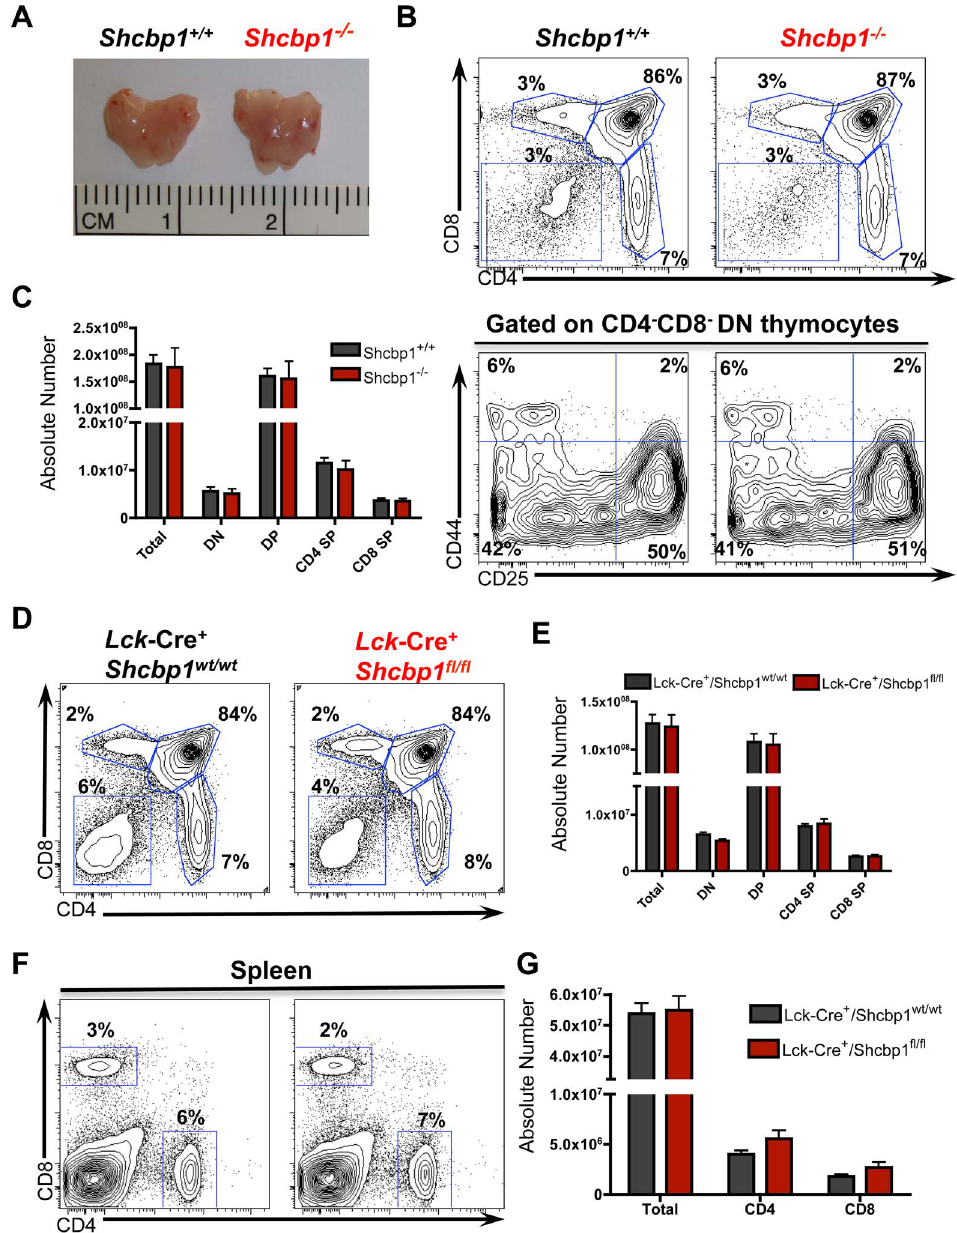
Figure 4. Loss of Shcbp1 does not impair T cell development. (A) Representative picture of the thymus from Shcbp1 + / + and Shcbp1 2 / 2 mice. (B) Flow cytometry of thymi isolated from 4-to-6 week old Shcbp1 + / + and Shcbp1 2 / 2 mice. Top panel is the surface marker expression of CD4 and CD8. Bottom panel shows surface marker expression of CD44 and CD25 gated on DN thymocytes (CD4 2 CD8 2 B220 2 Gr1 2 Ter119 2 CD11b 2 CD11c 2 ). Data presented are representative of n=4–6 mice per genotype of age-matched littermate controls. (C) Total cellularity and absolute number of thymic subsets in 4-to 6-week-old Shcbp1 + / + and Shcbp1 2 / 2 mice (n=4–6 mice of each genotype with age-matched littermate controls). (D) Flow cytometry of thymi isolated from Lck -Cre + / Shcbp1 wt/wt and Lck -Cre + / Shcbp1 fl/fl with analysis of cell surface markers CD4 and CD8 (representative of n=11 mice per genotype of age-matched littermate controls). (E) Total cellularity and absolute number of thymic subsets in 4-to 6- week-old Lck -Cre + / Shcbp1 wt/wt and Lck -Cre + / Shcbp1 fl/fl mice (n=11 mice of each genotype with age-matched littermate controls). (F) Flow cytometry for cell surface markers CD4 and CD8 in spleens isolated from 4-to-6-week old Lck -Cre + / Shcbp1 wt/wt and Lck -Cre + / Shcbp1 fl/fl mice (n=11 mice of each genotype with age-matched littermate controls). (G) Absolute numbers of splenic CD4 + and CD8 + T cells as well as total splenocytes from Lck -Cre + / Shcbp1 wt/wt and Lck -Cre + / Shcbp1 fl/fl mice (n=11 mice of each genotype).